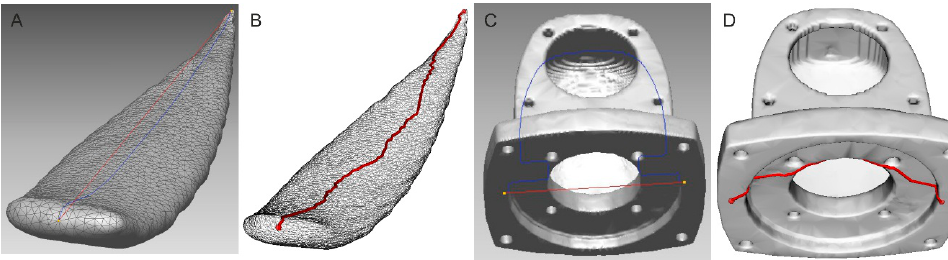
Figure 2. Finding the shortest path between points (part of an Aloe marlothii leaf): ( A ) A line projection onto the surface; ( B ) Triangle mesh-based; ( C ) An example of the incorrect shortest path; ( D ) The correct triangle mesh-based path.